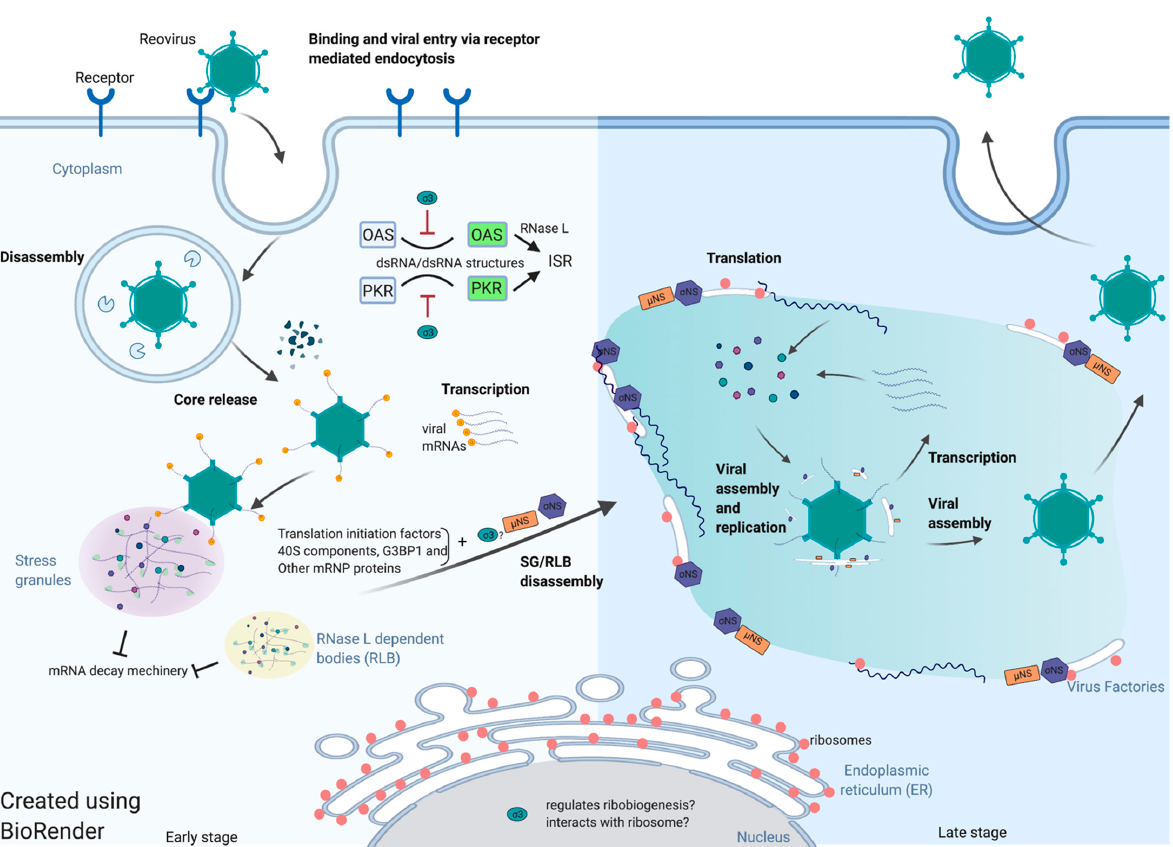
Figure 1. Spatiotemporal regulation of reovirus translation.